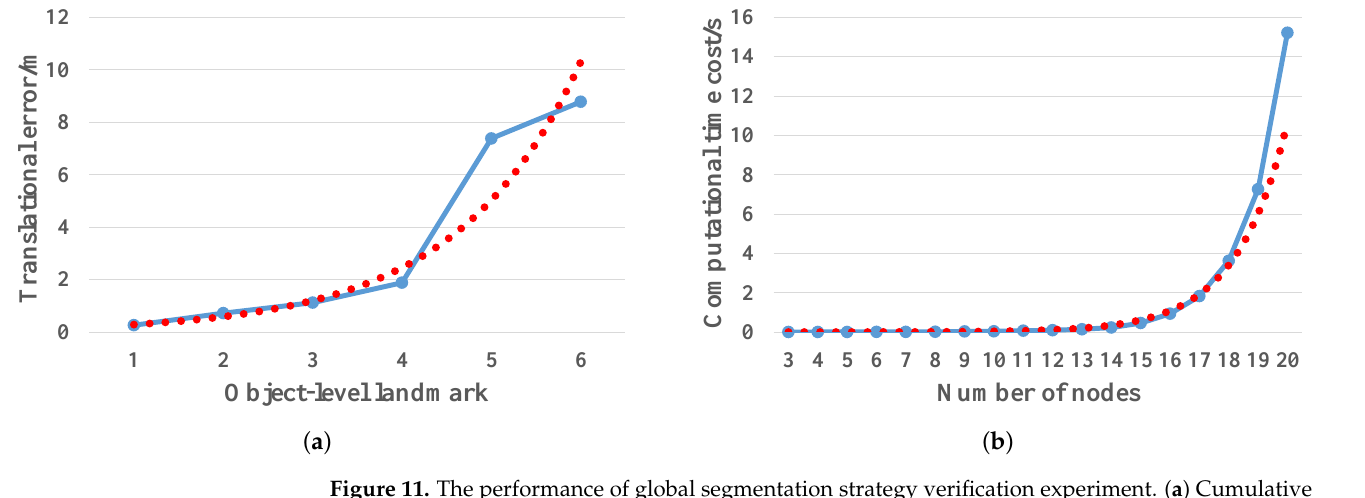
Figure 11. The performance of global segmentation strategy verification experiment. ( a ) Cumulative translation error. The solid blue line indicates the cumulative translation error of converting the six objects on the global topological path to the current robot coordinate system. The red dashed line indicates the exponential trend of the error. ( b ) Computational time cost. The solid blue line indicates the computational time cost of Bernstein polynomials as the number of nodes increases. The red dashed line indicates the exponential trend of the computational time